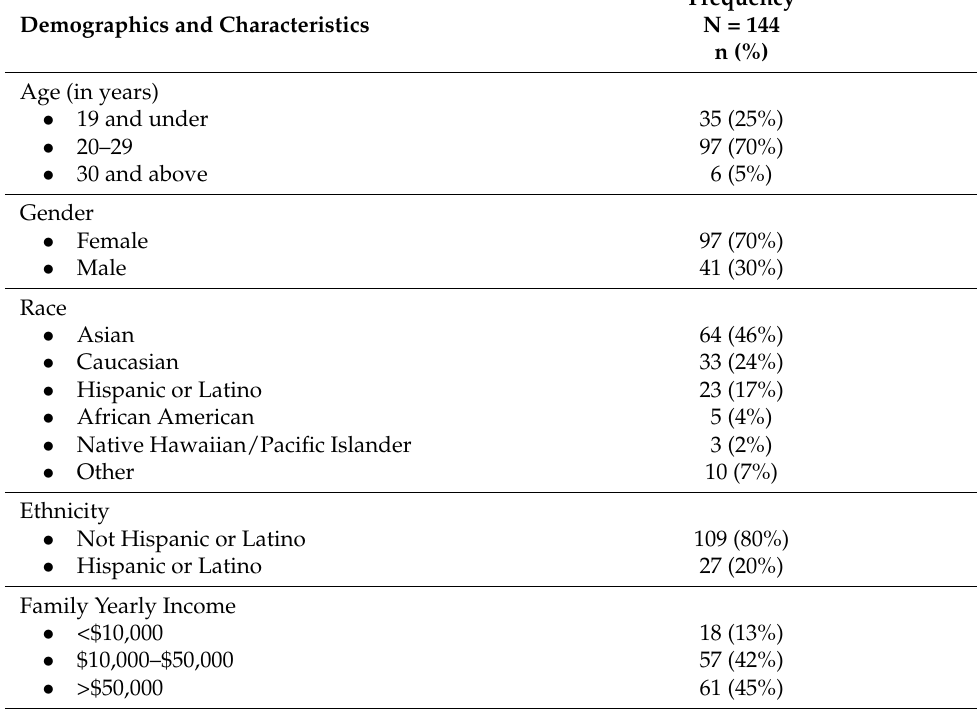
Table 2. Summary of Participant Demographics and